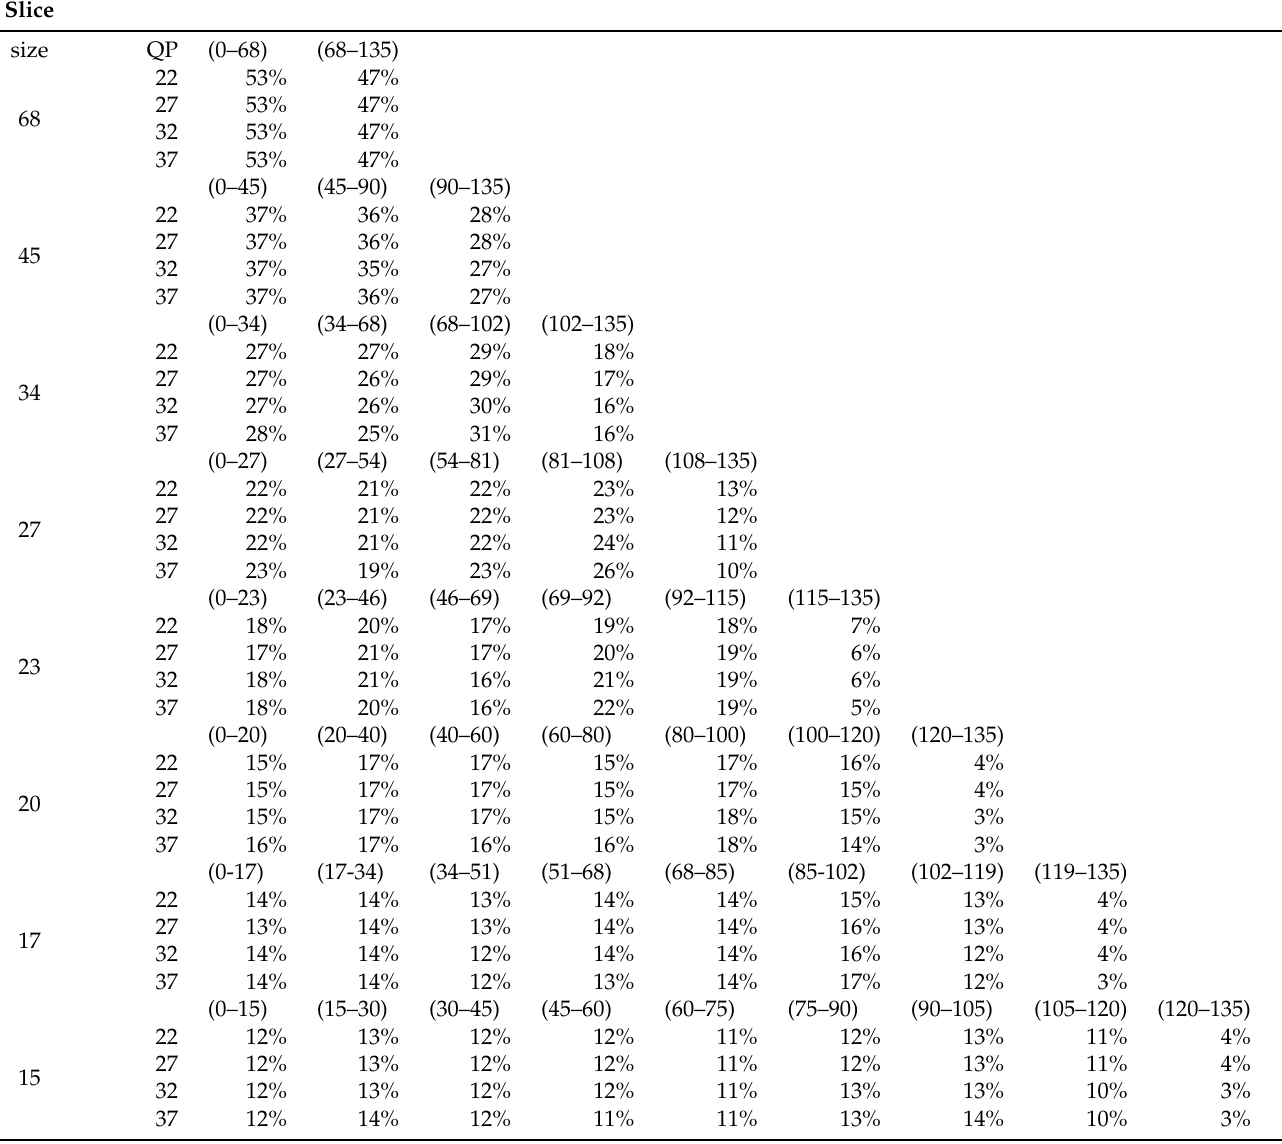
Table 7. Computational cost per slice for Park Scene video